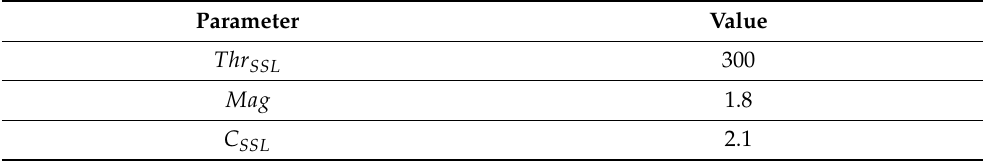
(cid:2869) ap- (cid:3021)(cid:3035)(cid:3045) (cid:3268)(cid:3268)(cid:3261) (cid:2939) (cid:3151)(cid:3151)(cid:3144) (cid:2869)